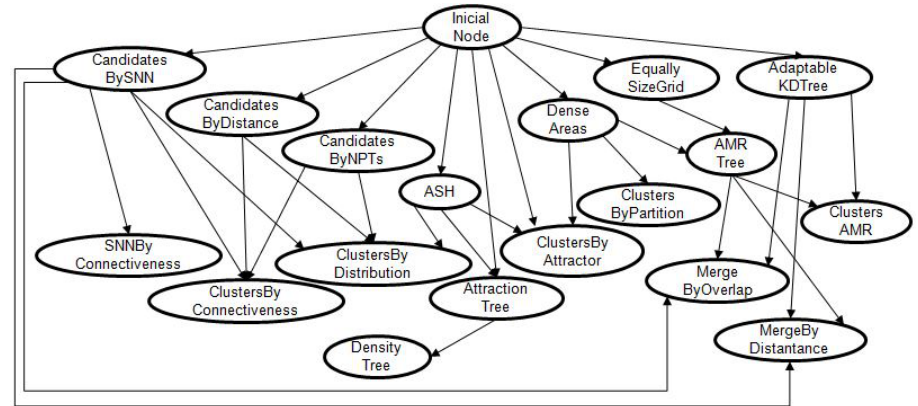
Figure 1. The building blocks’ directed acyclic graph (DAG) as the auxiliary data structure to the estimation-of-distribution algorithm